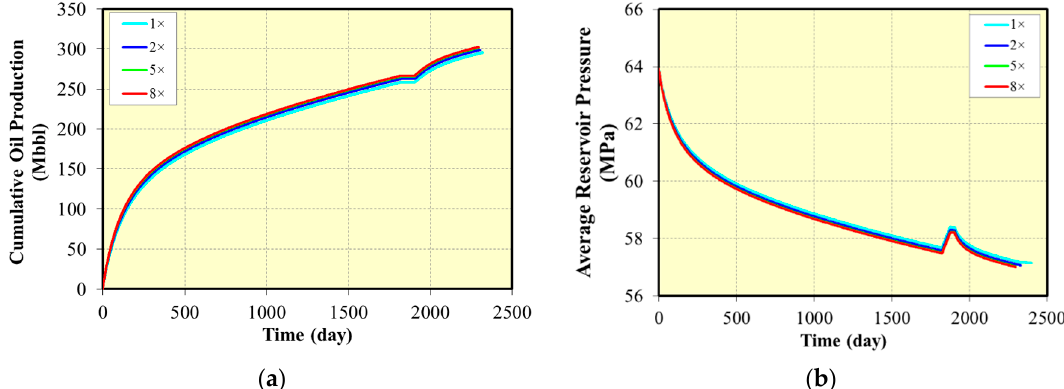
Figure 24. Effect of different permeability magnifications in the SRV region with one huff-n-puff cycle on oil production and reservoir pressure: ( a ) Cumulative oil production for different magnification of permeability in SRV region; ( b ) Average reservoir pressure for different permeability magnifications in the SRV region.